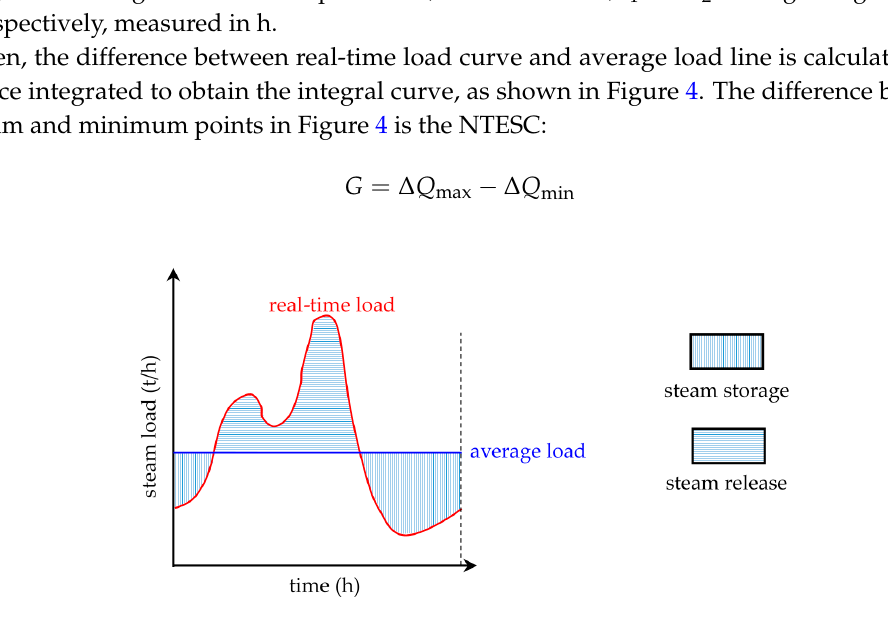
Figure 3. Steam consumption load curve during a cycle. The curve denotes the real-time load; the straight line denotes the average load; the shadow in horizontal line denotes the steam storage; and the shadow in vertical line denotes the steam release.